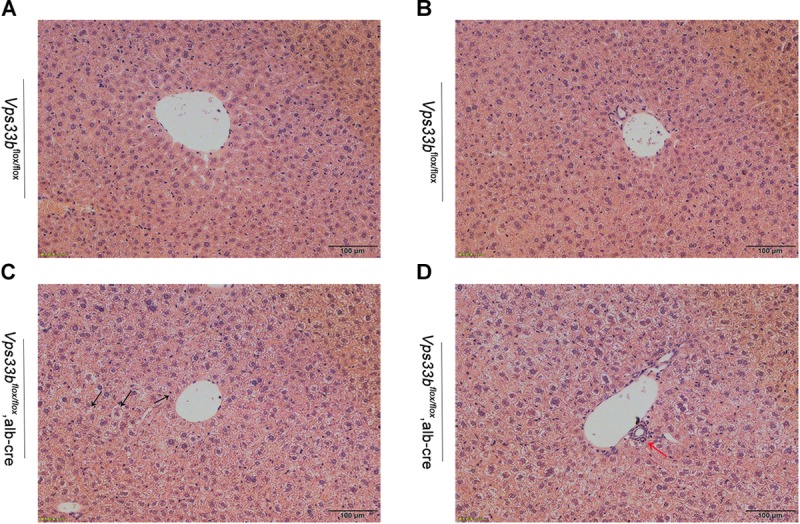
Representative H&E-stained livers from Vps33bflox/flox
(A,B) and Vps33bflox/flox, alb-cre mice (C,D). Necrosis of hepatocytes (black arrow) and ductal proliferation (red arrow) were observed.